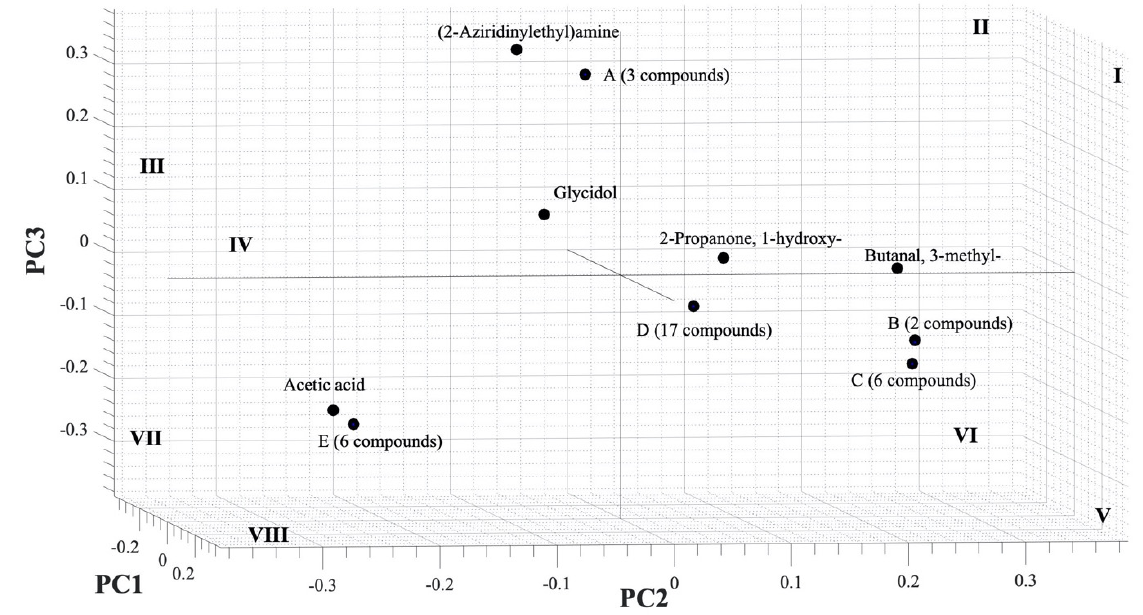
Figure 4. Loading plot of PCA from GC-MS result.